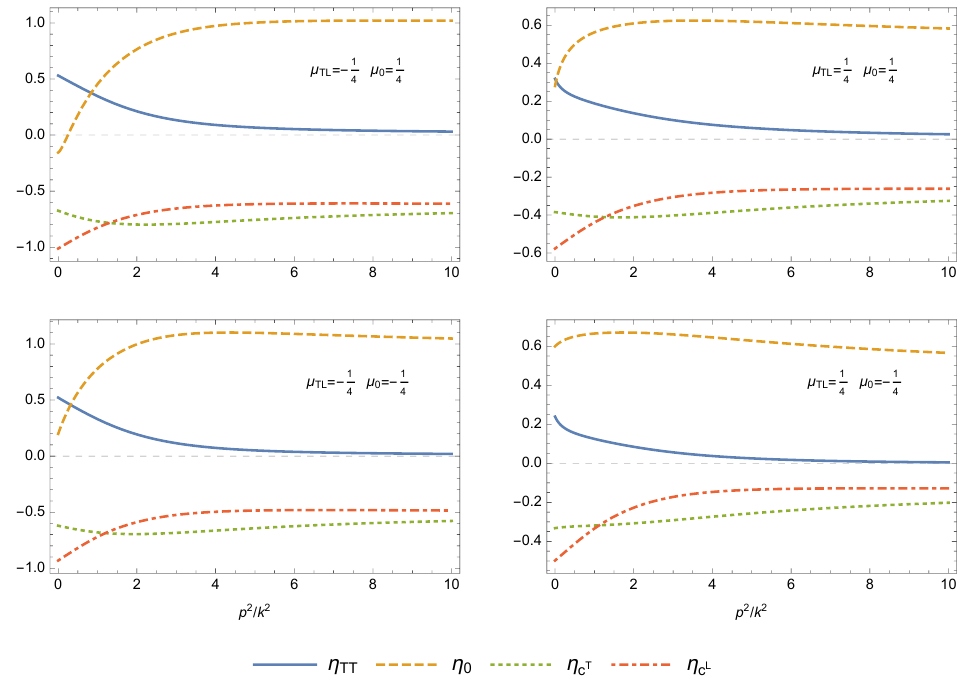
Figure 4. Gap dependence of the dynamical anomalous dimensions for the choices d = 4, g = 1, β h = 1 and the regulator (83). For clarity, we have reinstated k in the momentum